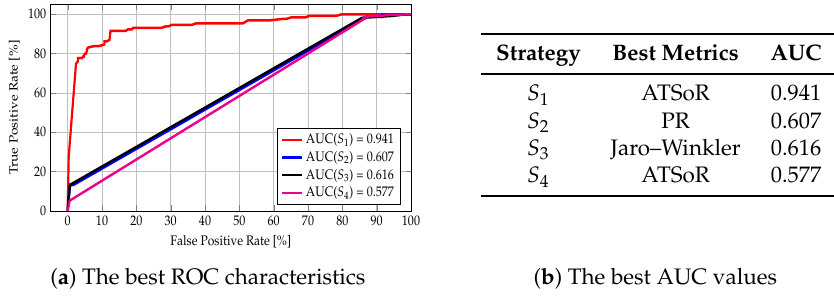
Figure 15. The best: AUC values ( b ) and ROC curves characteristics ( a ) for attribute WWW .